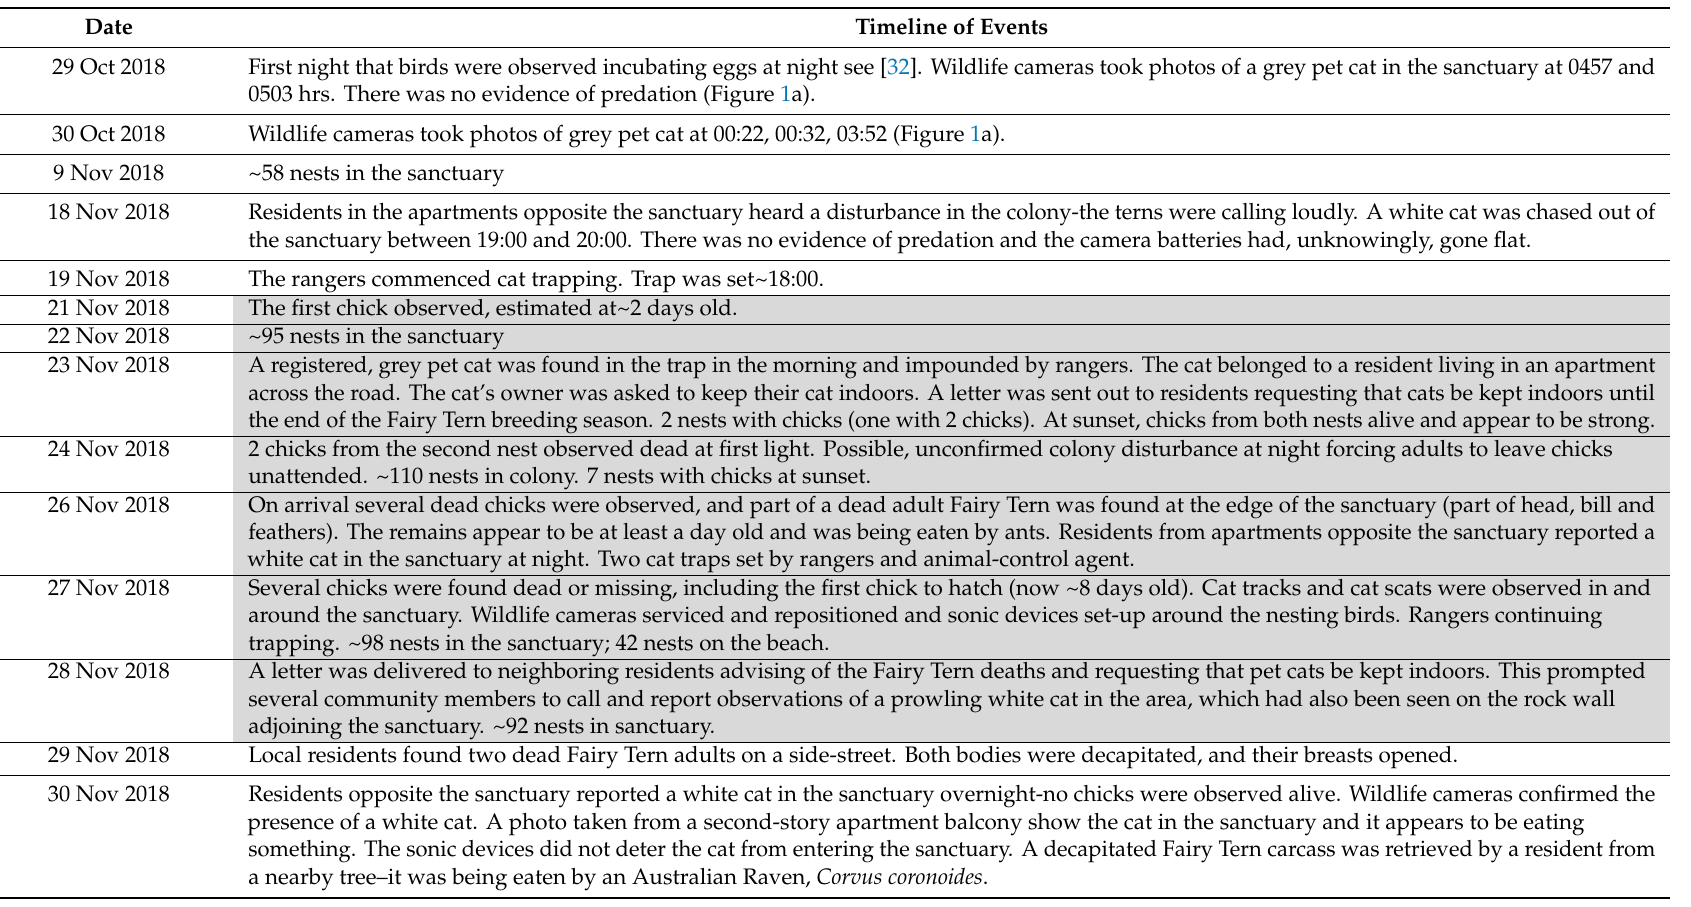
Table 2. Timeline showing colony development at the sanctuary in Mandurah, incursions by a pet and semi-feral cat, depredation events and management activities undertaken during the 2018 breeding season. The grey shading shows the period in which sunrise-to-sunset observations of the nesting colony were